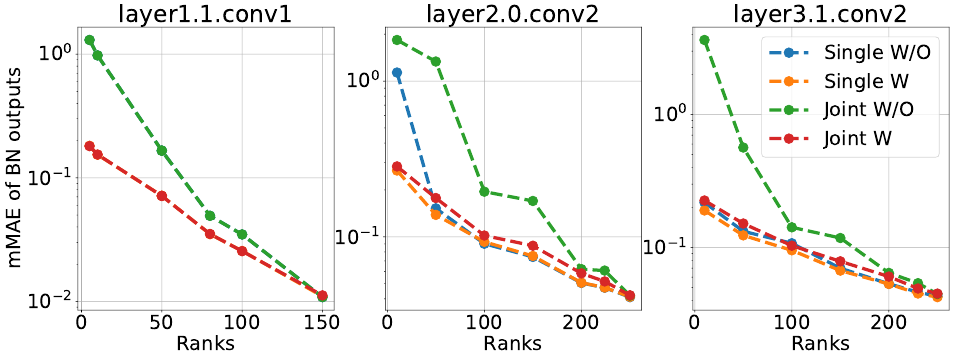
Figure 6. Maximum of the MAE over the channels (mMAE) between outputs of the BN layers subsequent to the original and decomposed layers. In the Single setting, the compressed model has only one decomposed layer, while in the Joint setting, three layers are simultaneously decomposed. W/O corresponds to the case without calibration of the BN statistics, while W corresponds to the case with calibration of the BN statistics. The x -axis shows the CP rank. Note: for the first decomposed layer layer1.1.conv1 (left subfigure), the results of the Single and Joint settings